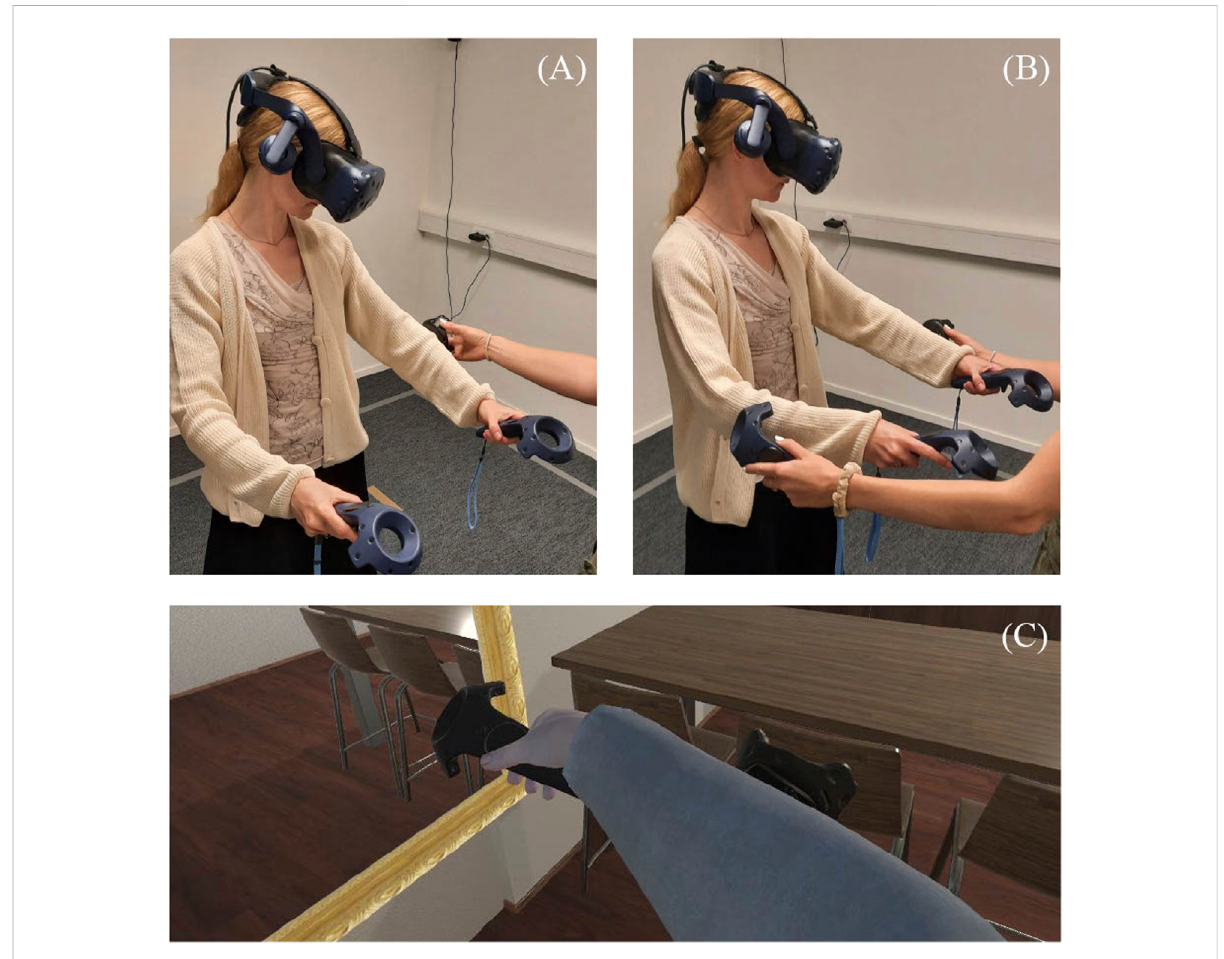
FIGURE 3 Depiction of the VTS procedure. Note. (A) Congruent VTS condition, controller touches arm, (B) Incongruent VTS condition, left controller touches arm, right controller does not touch the arm (from the experimenter ’ s perspective), (C) Participant ’ s viewpoint during the VTS procedure in both conditions, seeing a controller stroking the virtual